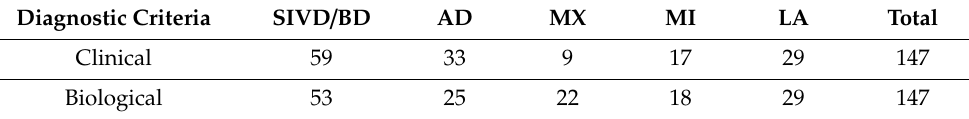
Table 2. Diagnosis Count based on Clinical and Biological Criteria. Diagnostic